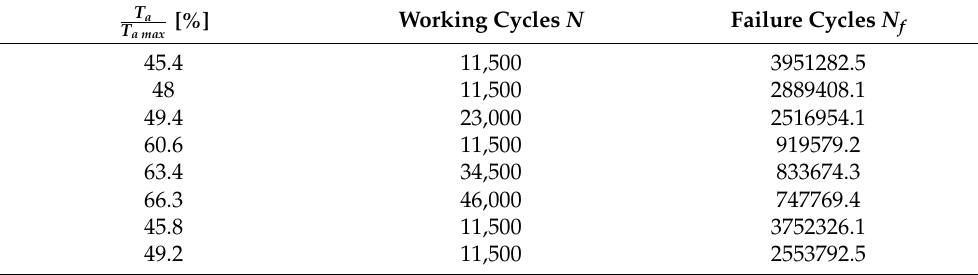
Table 7. Torque amplitude, working cycles and failure cycles for the ICE vehicle model.